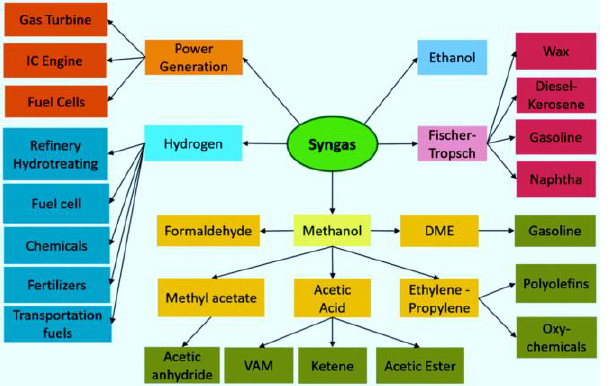
Figure 20. The potential routes for syngas exploitation. Reproduced with permission from Ref. [178].